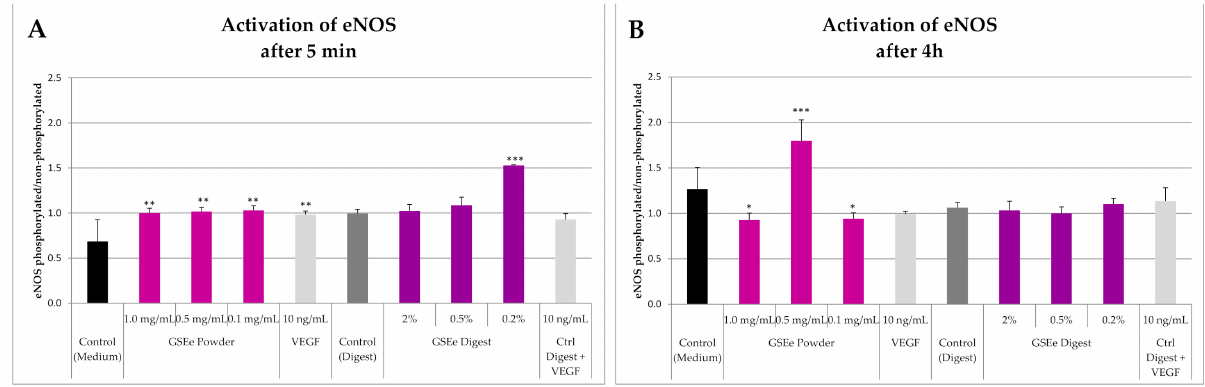
Figure 1. Effect of GSEe powder and digest on phosphorylated eNOS after 5 min ( A ) and 4 h ( B ). Values are given as mean ± S.D., n = 4. *** = p < 0.001; ** = p < 0.01; * = p < 0.05 calculated with one-way ANOVA and Dunnett’s post-test (GSEe versus control). GSEe: grape seed extract Enovita; eNOS: endothelial Nitric Oxide Synthase; VEGF: Vascular Endothelial Growth